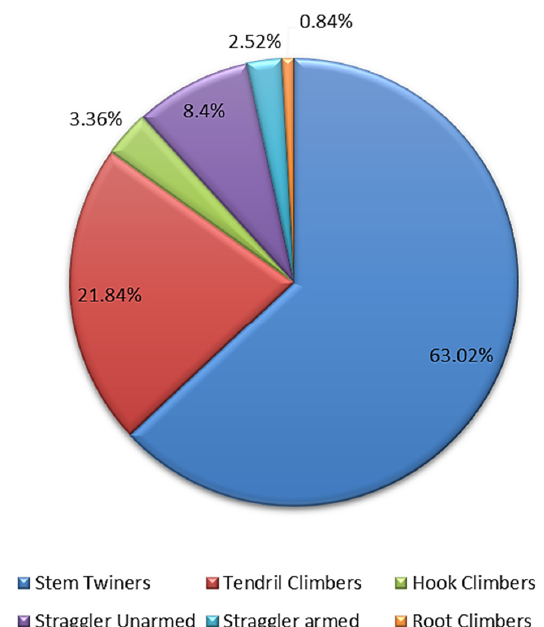
Figure 2. Percentage of different climbing modes found in climbers of SBR, Odisha,